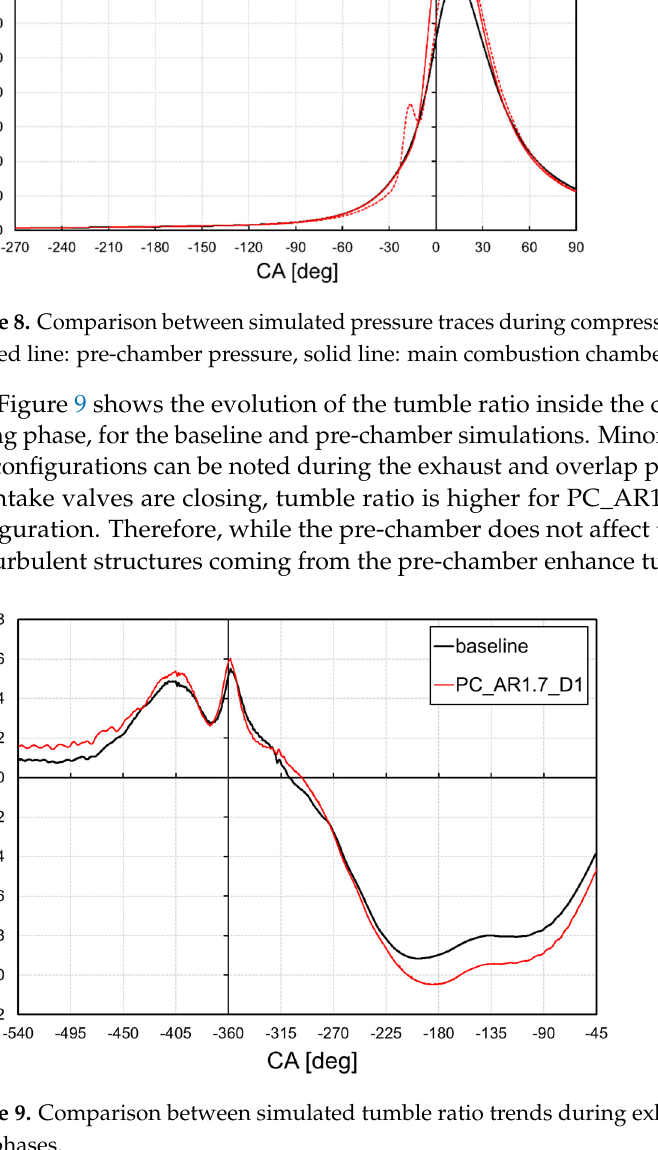
ured ( a ) in-cylinder pressure, ( b ) burned mass fraction.